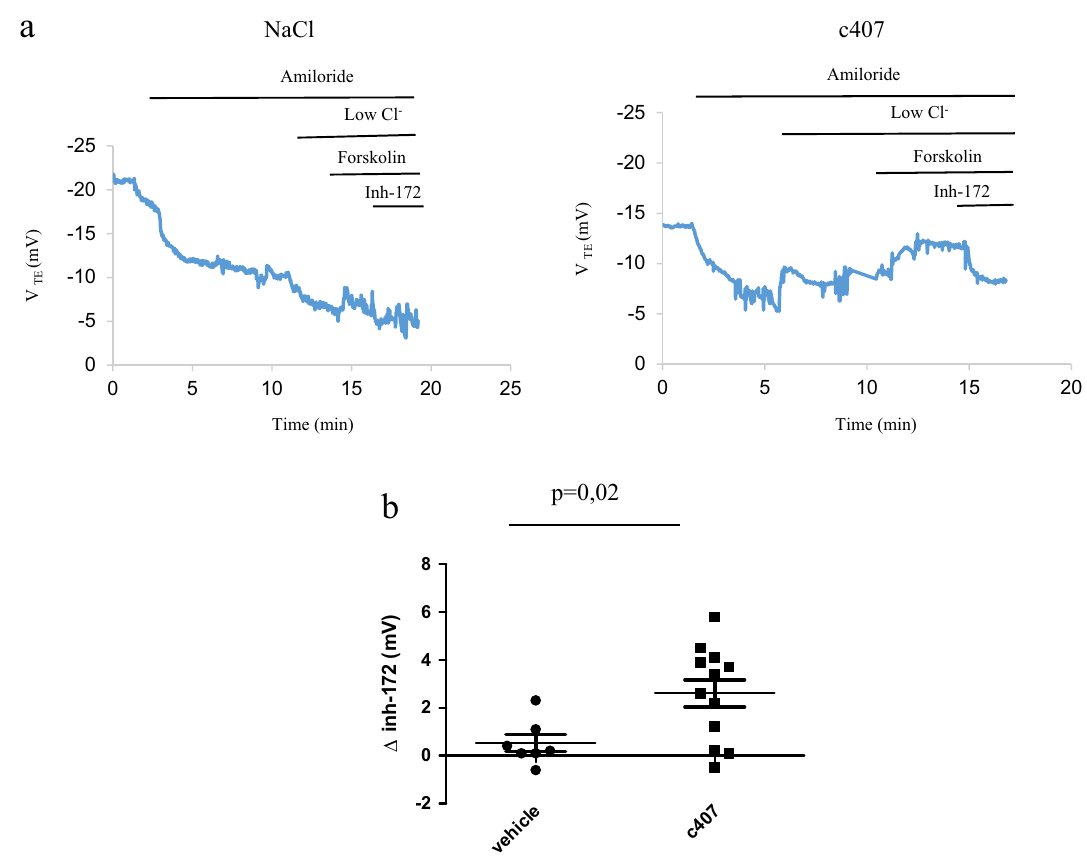
Figure 3. Effects of subcutaneous administration on Nasal Potential Difference in F508del Cftr tm1Eur mice. ( a ) Tracing of Nasal Potential Difference performed in a F508del Cftr tm1Eur mouse after subcutaneous administration for 28 days of NaCl 0.9% (left panel) or c407 (22.3 mg) (right panel). ( b ) Summary of Nasal Potential Difference changes after perfusion of Forskolin 10 µM followed by Inh-172 5 µM in low Cl − solution (∆ Inh-172) in mice treated with NaCl 0.9% (n = 7) or c407 (n = 12).